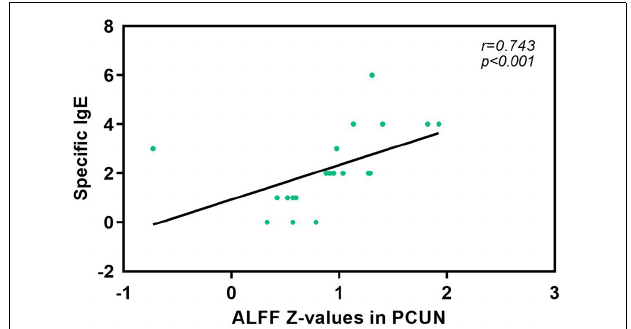
FIGURE 5 | Significant correlation analysis between AR patients’ ALFF values in the PCUN and specific IgE results. Spearman’s correlation analysis between the ALFF z -values in the PCUN and specific IgE: n = 20, r = 0.743, p < 0.001. ALFF, amplitude of low-frequency fluctuation; AR, allergic rhinitis; PCUN,